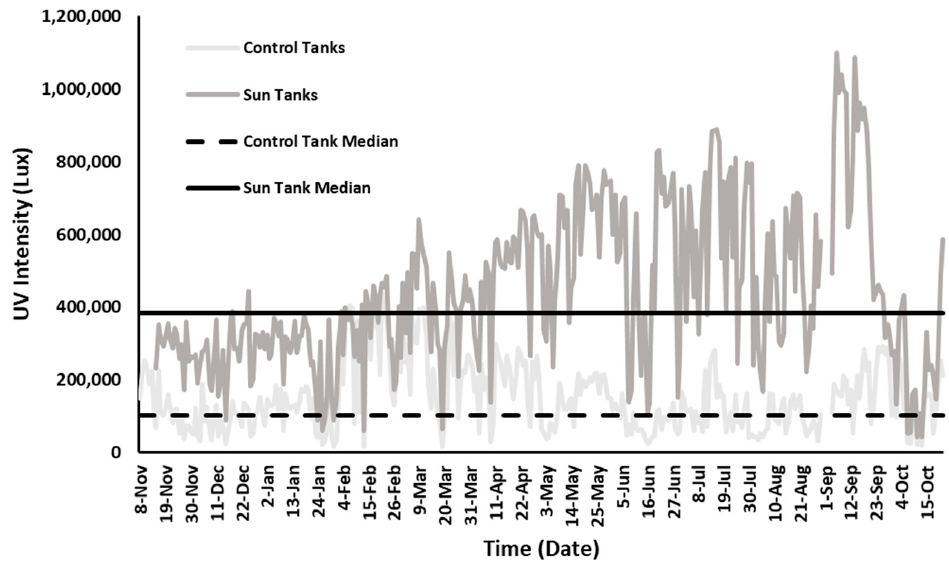
Figure 2. Daily fluctuations in UV intensity for control (low sun exposure) and treatment (high sun exposure) tanks over the course of a year. Median values for the control tanks and sun treatment tanks are significantly different ( p < 0.001).